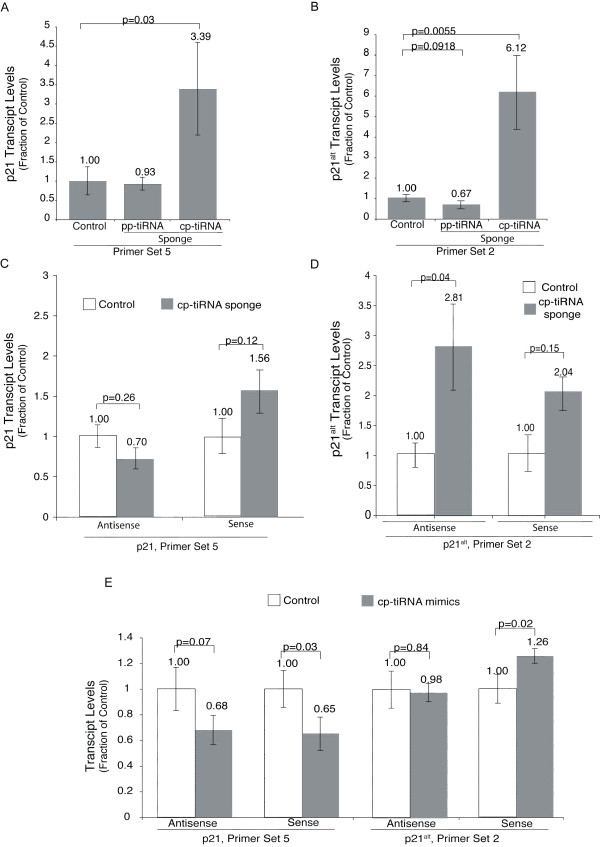
The effects of transcription initiation (ti)RNA sponges and mimics on p21 (cyclin-dependent kinase inhibitor 1A gene, also known as CDKN1A) expression. (a) Transfection by the CCCTC-binding factor (CTCF) proximal (cp)-tiRNA sponge resulted in an increase in p21 mRNA and (b) p21alt transcript levels. Reverse transcription was non-specifically primed and cDNA was analyzed by quantitative (qPCR) using primer set 2 for p21 mRNA and primer set 1 for p21alt RNA. (c) Further validation of the results in (a) and (b) were confirmed by transfection with the cp-tiRNA sponge followed by strand-specific quantitative reverse transcription (qRT)-PCR which showed an increase in both antisense and sense p21alt transcript levels, and (d) an increase in sense p21 mRNA. (e) Transfection of cp-tiRNA mimics resulted in a decrease in both sense classical and alternate p21 transcripts. (a-e) Samples were analyzed at 72 h post transfection. The averages of samples transfected in triplicate are shown, error bars represent the standard errors of the means, and P values from paired t tests are shown.